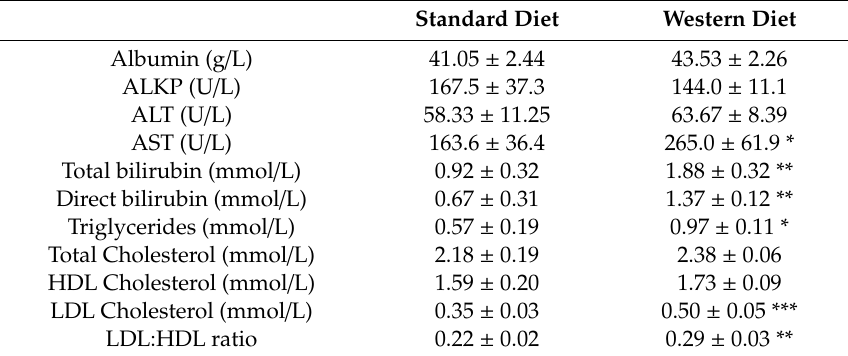
Table 1. Biochemical parameters of liver function in standard and Western diet